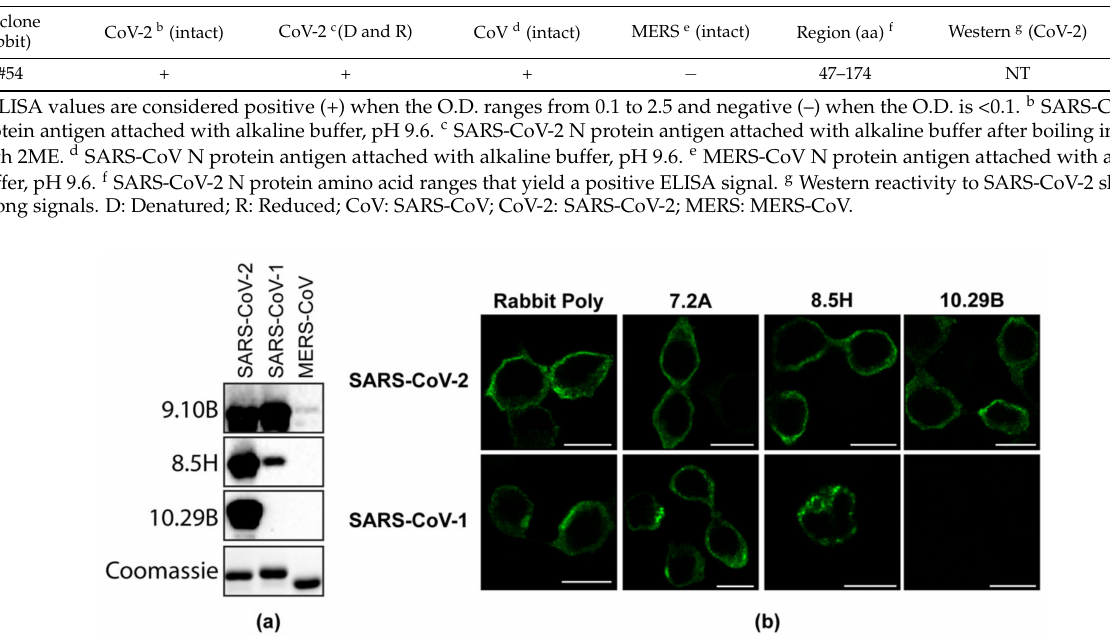
Figure 2. ( a ) Western blot showing purified N proteins from SARS-CoV, SARS-CoV-2, and MERS-CoV probed with monoclonal N antibodies 9.10B, 8.5H, and 10.29B. A Coomassie-stained polyacrylamide gel shows the equal loading of the